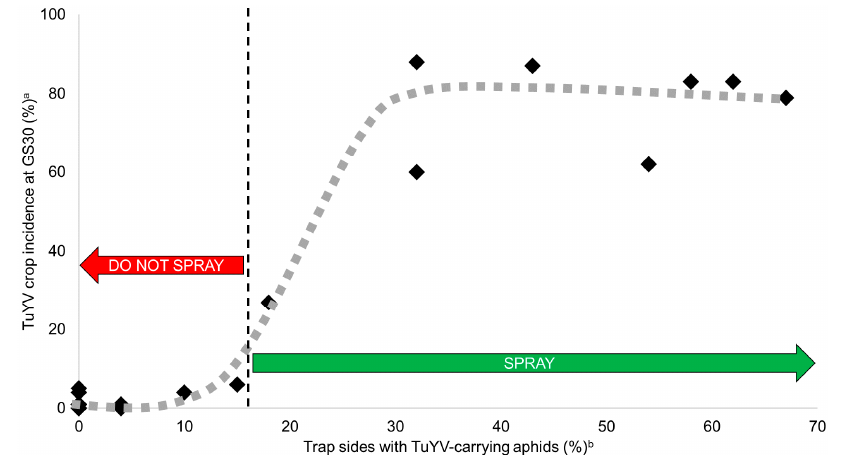
Figure 2. Relationship between canola ( Brassica napus ) crop Turnip yellows virus (TuYV) incidence at GS30 (beginning of stem elongation) and percentage (%) of trap sides with TuYV-carrying aphids deployed during a six-week period from pre-emergence until GS15 (five-leaf stage). Implication for insecticide application decision illustrated by red (do not spray) and green (spray) arrows. a Tip leaf samples of 100 to 200 canola plant tested for TuYV by enzyme-linked immunosorbent assay. Growth stages determined using the ‘BBCH’ decimal system [4] . b Yellow sticky traps deployed on top of fence adjacent to canola crop and collected every two weeks. Aphids caught on each trap side were pooled, homogenized, and the crude extract tested for TuYV by reverse transcription loop-mediated isothermal amplification.